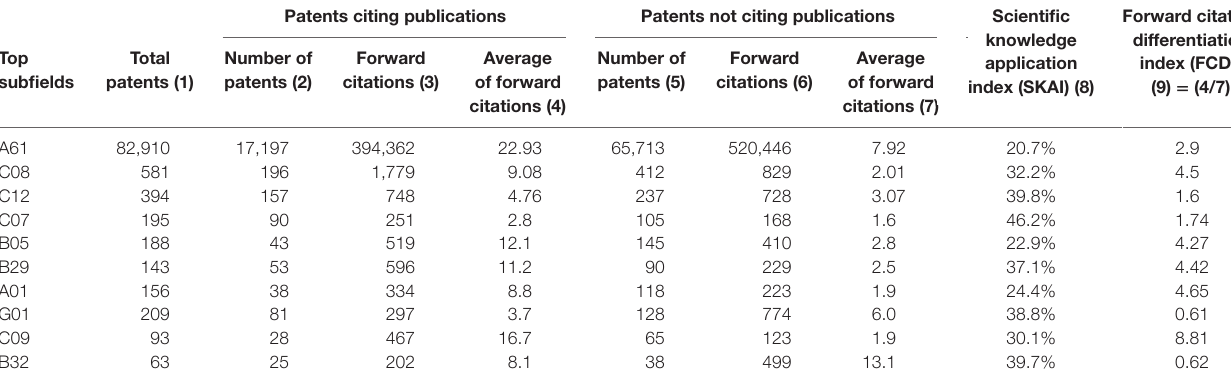
TaBle 3 | Comparison of scientific knowledge application in 10 subfields,